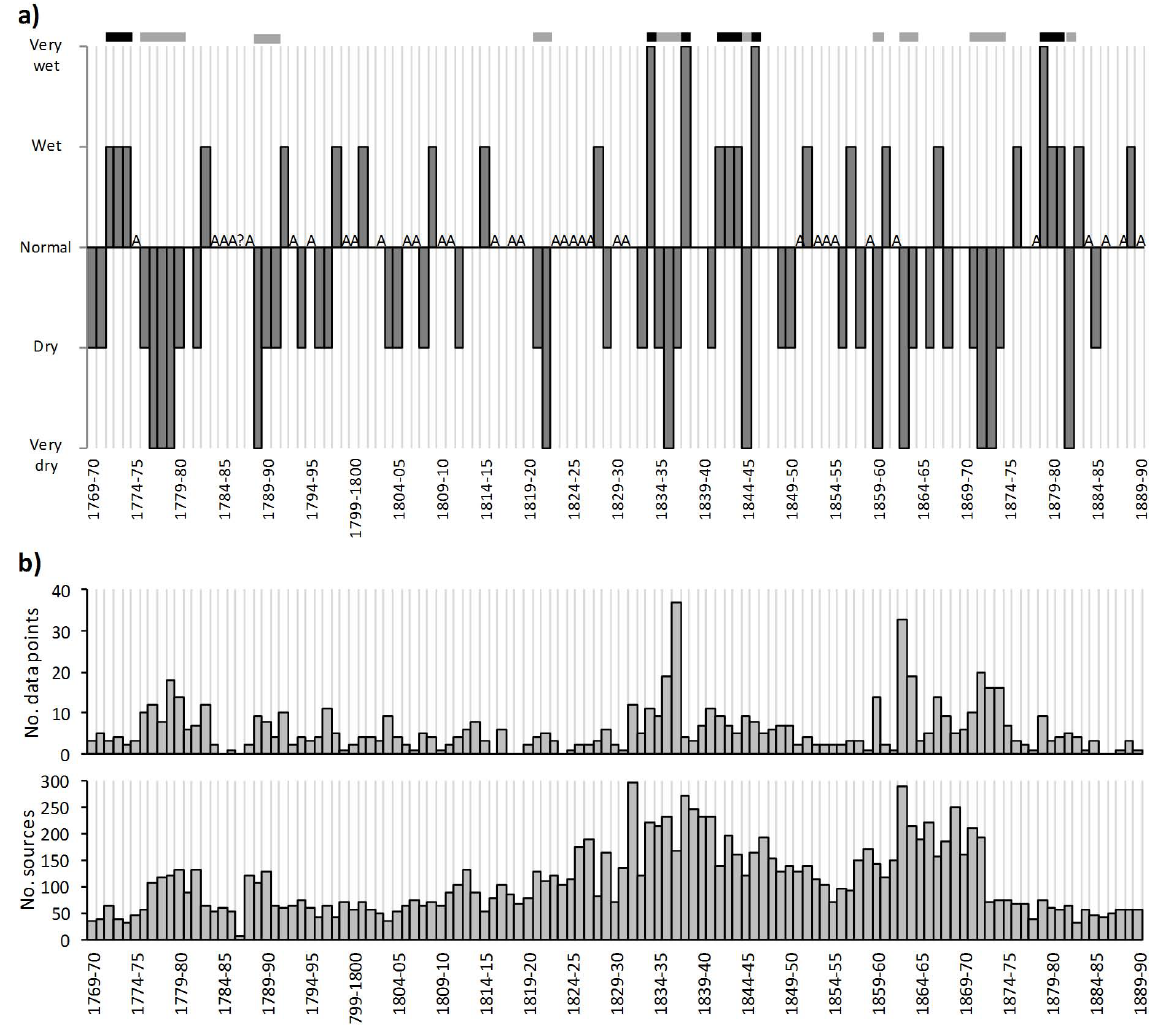
Fig. 3. (a) Document-derived chronology of predominant rainfall conditions throughout Antigua, 1769–70 to 1889–90. A and ? denote assumed “normal” and unclassified rain-years respectively. Major dry (wet) phases highlighted in grey (black) at top of chart. (b) Number of data points and documents available for each